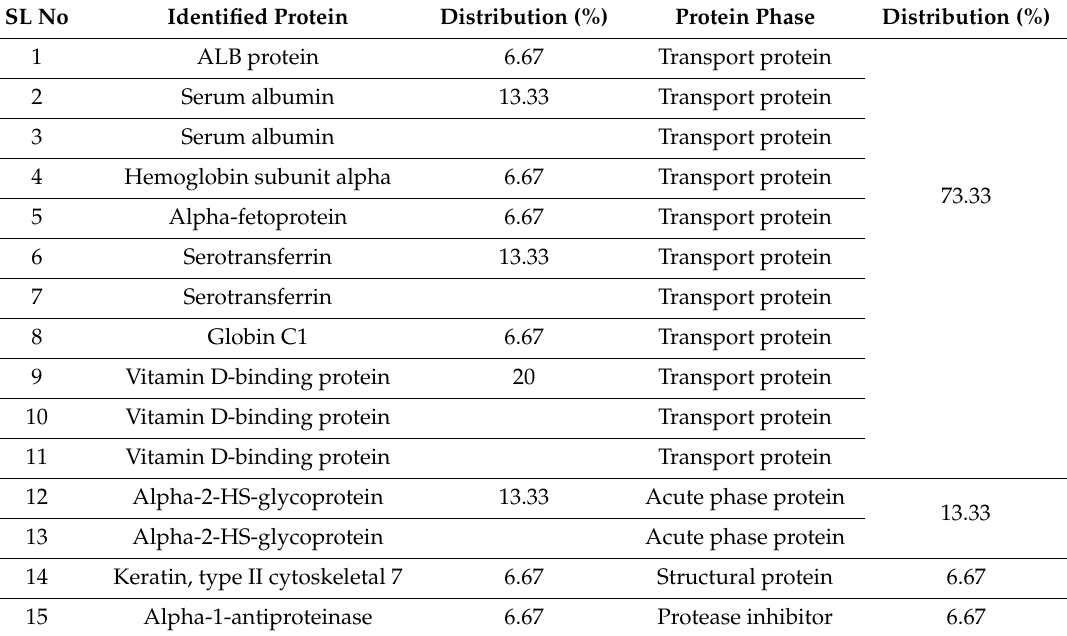
Table 9. Protein distribution (%) around CMCA NPs in 10% FBS.